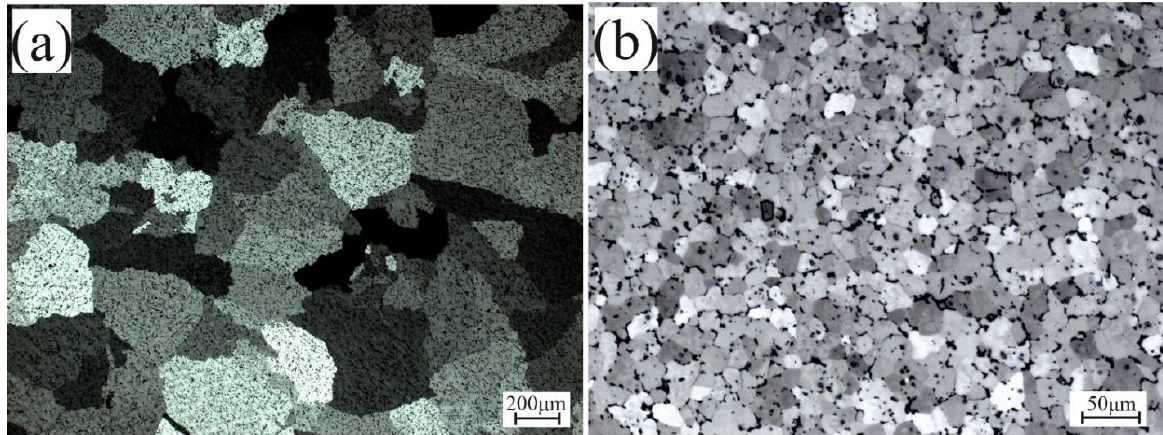
Figure 4. The as-cast optical photography of investigated alloys: ( a ) Al-2.5% Mg alloy; and ( b ) Al-2.5% Mg + TiB modified alloy.